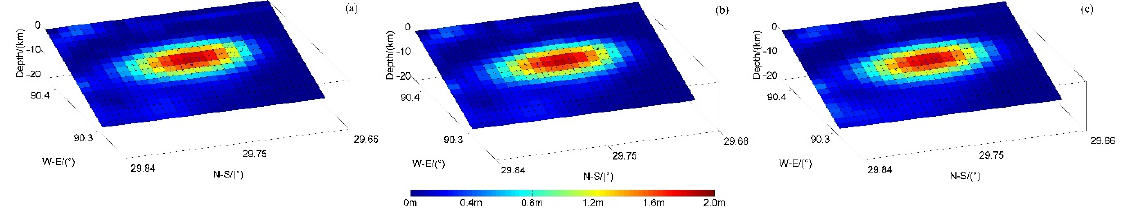
Figure 11. Slip distributions inferred from the DInSAR observations. Panels ( a ); ( b ); and ( c ) correspond to the HOmogeneous with Topography (HOT) model, the LAyering with Topography (LAT) model, and the HEterogeneous with Topography (HET) model, respectively. Color scale shows slip movement in m.